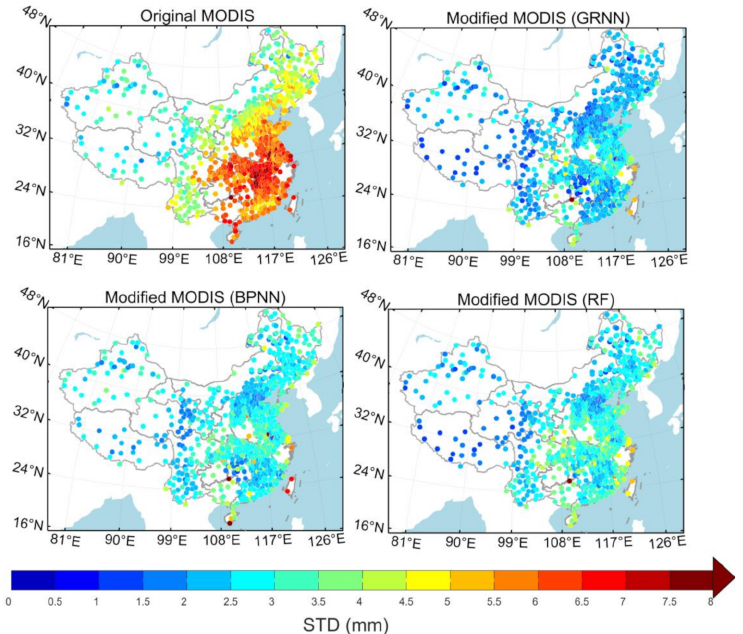
Figure 9. PWV STDs at GNSS sites which are based on monthly model